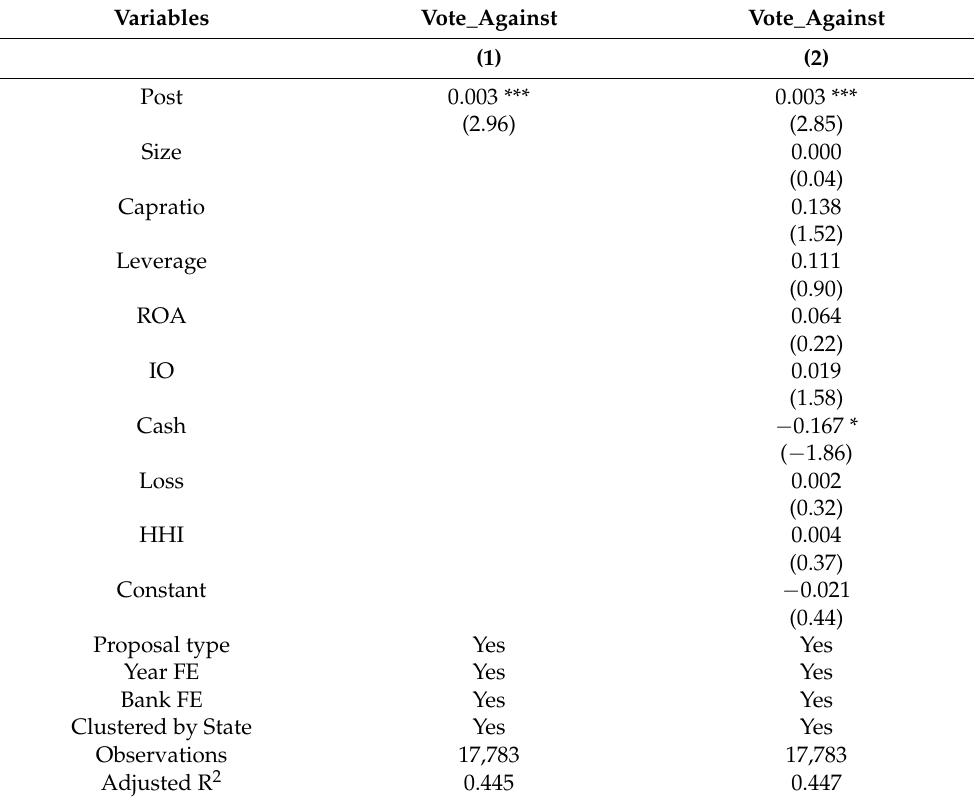
Table 2. Baseline